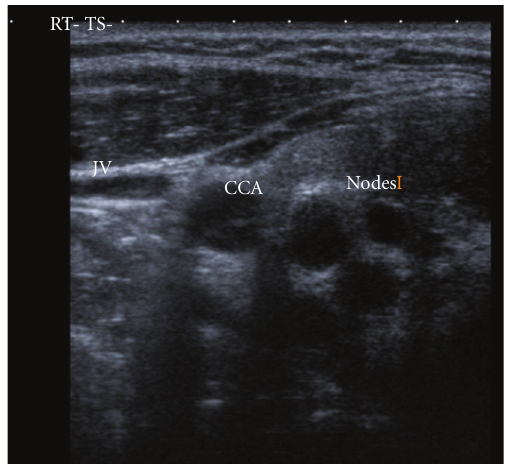
Figure 3: Right lateral neck showing abnormal